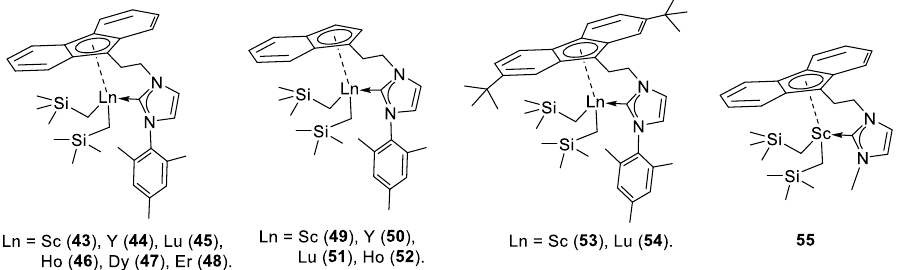
Figure 12. NHC side-armed half-sandwich Ln complexes.